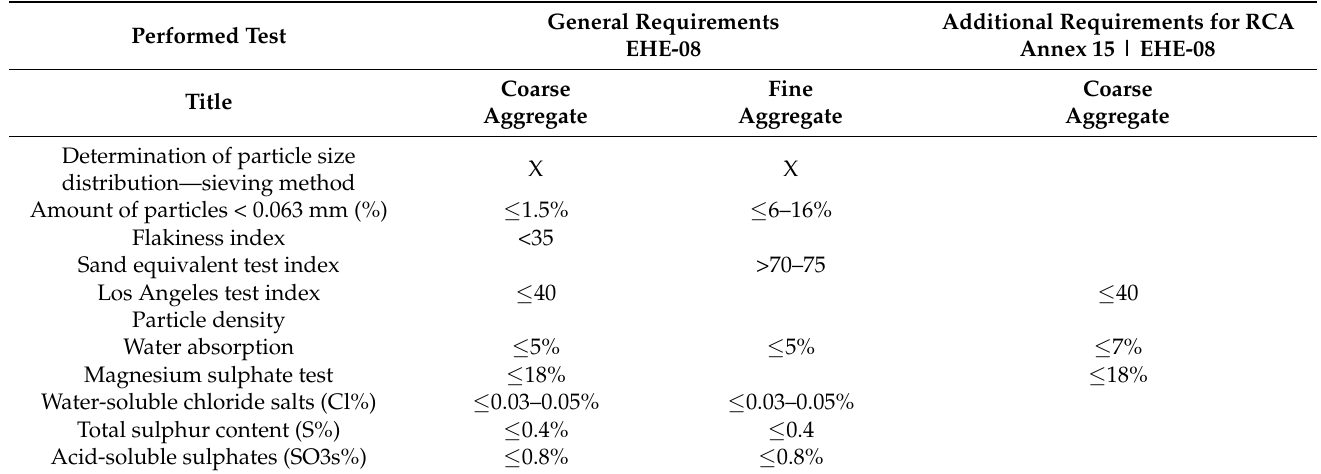
Table 3. EHE-08 technical requirements for aggregates for concrete manufacture